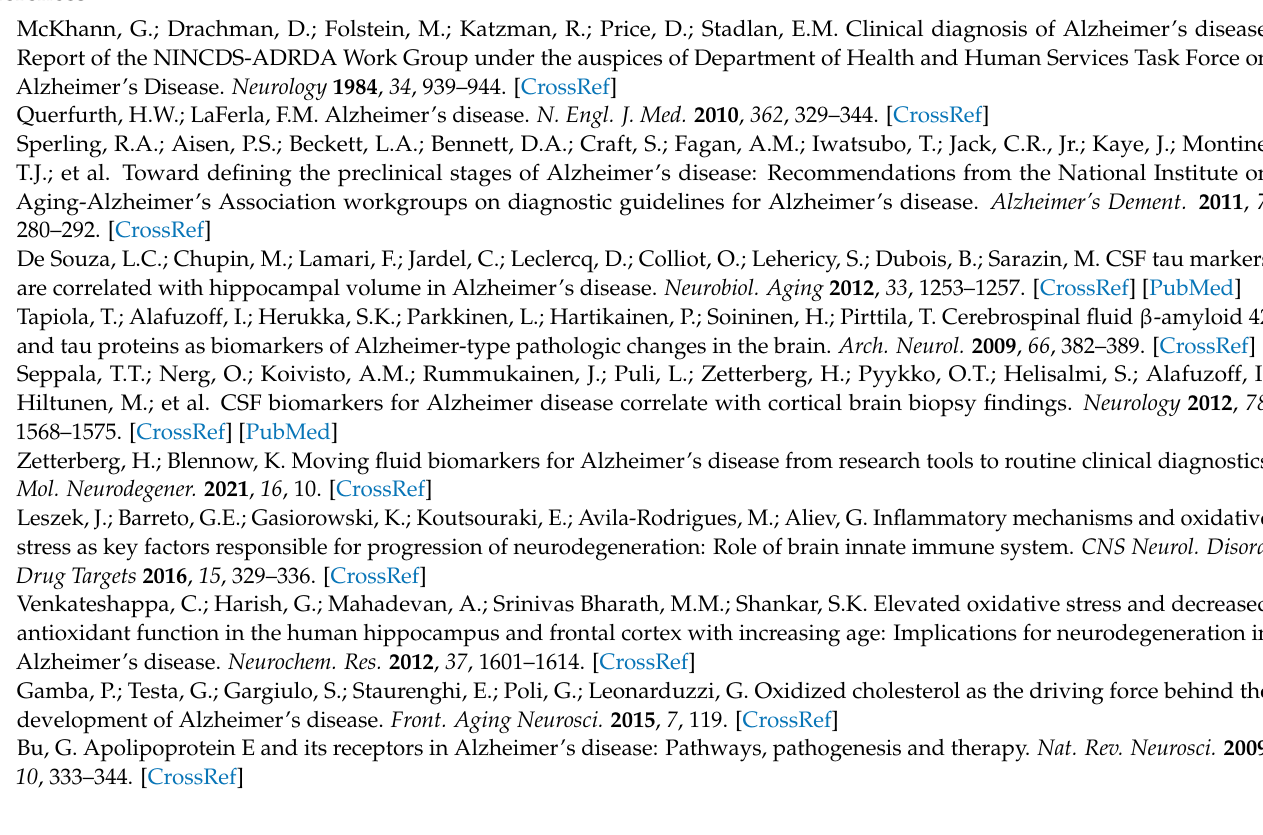
Funding: This work was supported by the University of Turin